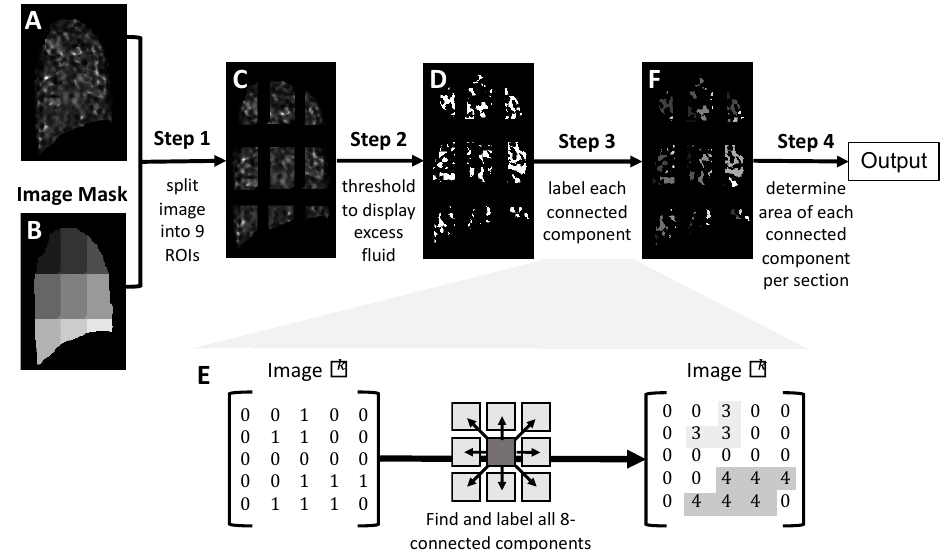
Figure 3. Graphical representation of image processing technique. ( A ) Input MR density image of a sagittal slice of the lung. ( B ) Input image mask identifying 9 ROIs of the lung. ( C ) The resulting image from step 1 after the MR density image is divided into 9 ROIs using the mask. ( D ) Resulting images of the excess fluid in each lung ROI from the thresholding procedure in step 2. ( E ) 8-connected components are identified and labeled using unique integers. ( F ) The resulting image after step 3 displays the labeled connected components. The output of the image processing procedure is the area and location of each connected component calculated in step 4.